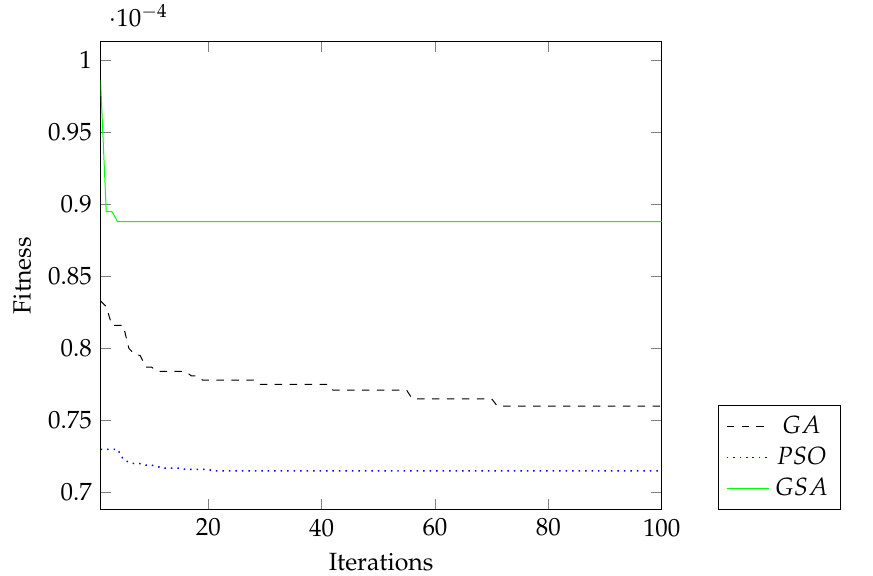
Figure 3. Convergence curves of the 4 kVA single-phase transformer using the GA, PSO and the GSA methods.